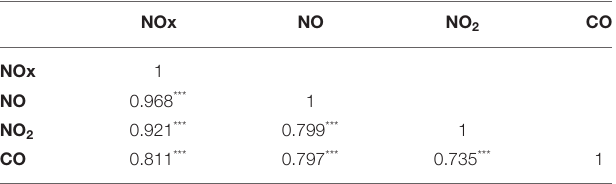
TABLE 5 | Description correlation matrix for air